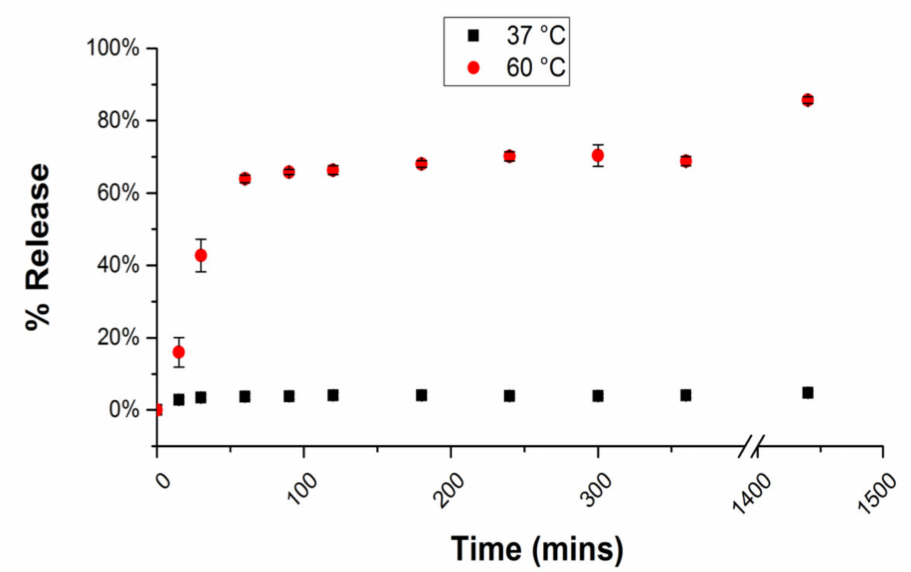
Figure 7. Release of fluorescein-labeled 40 K MW dextrans from HByp4-Fe(II) microcages at 37 and 60 ◦ C in phosphate buffer (10 mM, pH 7.0) as monitored by the fluorescence analysis of the